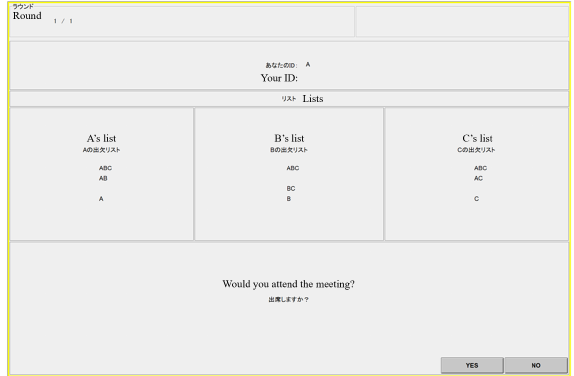
Figure A1. Treatment SIM screenshot.